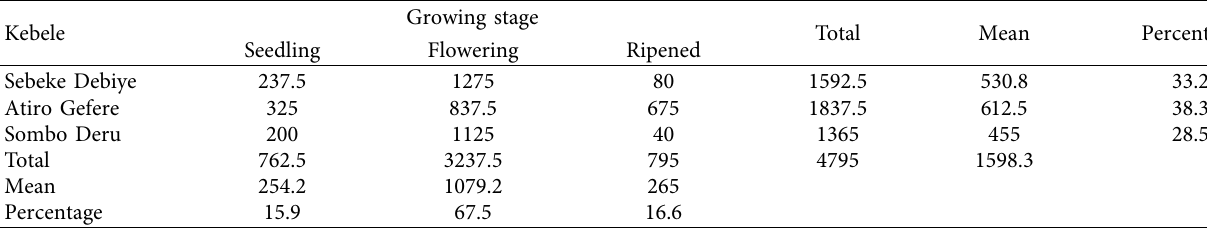
Table 7: Maize crops fed on at diferent stages in m 2 by the grivet